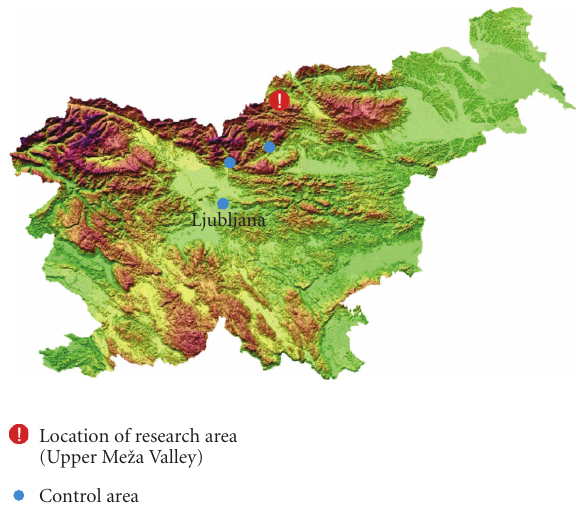
Figure 1: Map of Slovenia with the research area and the three areas of the control